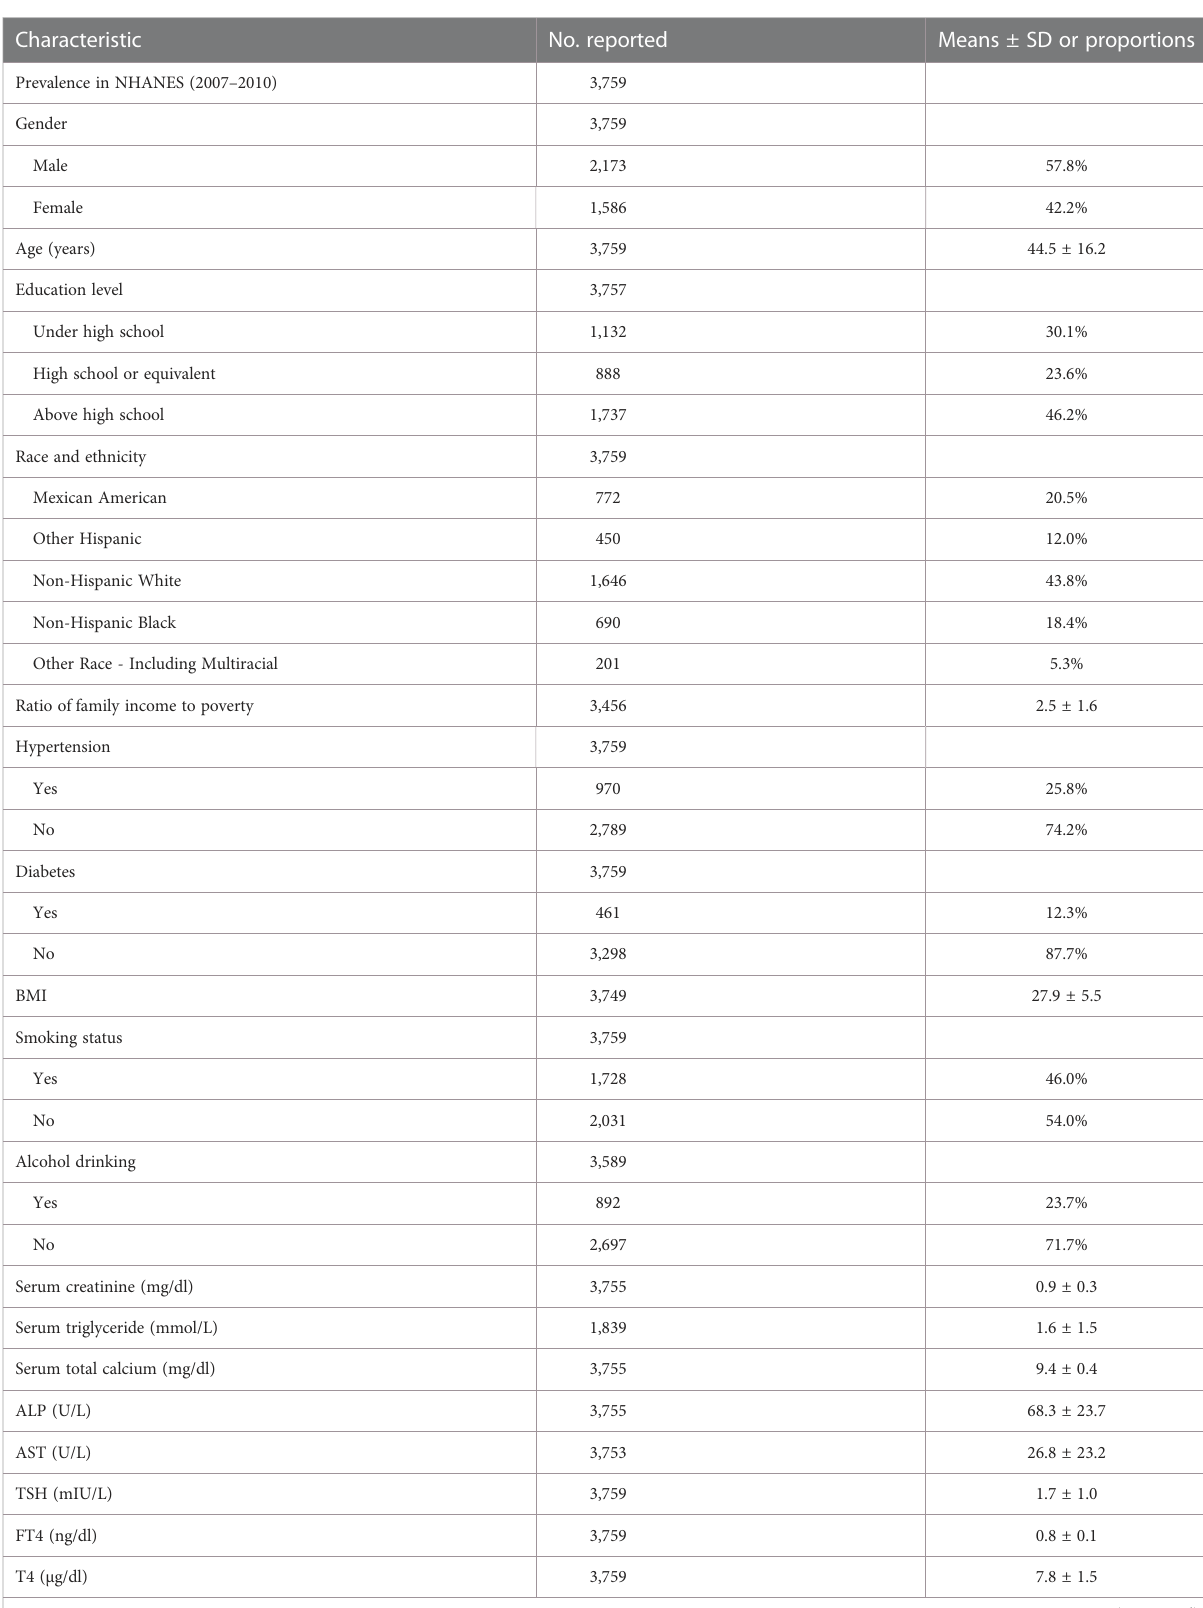
TABLE 1 Characteristics of the